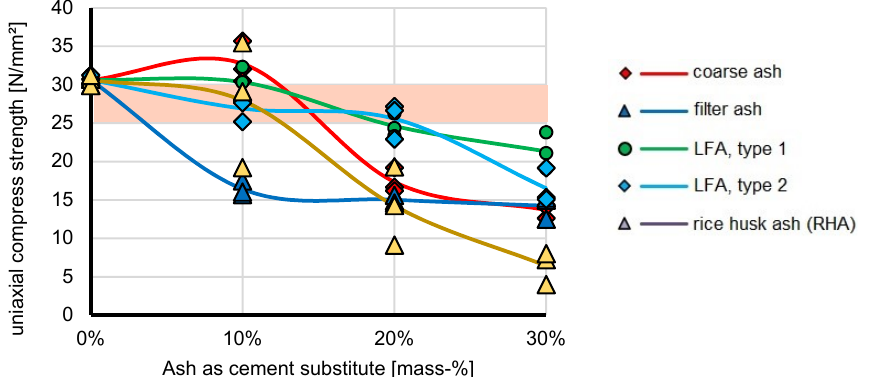
Figure 7. Results of unconfined compressive strengths of the ash test series.